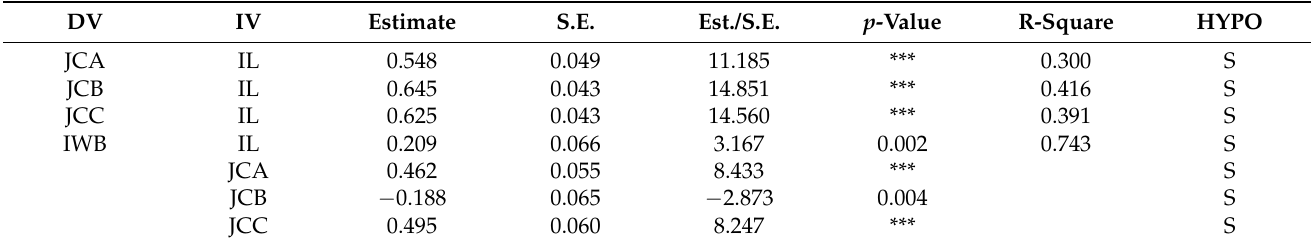
Figure 2. Path diagram. Table 3. Structural model.